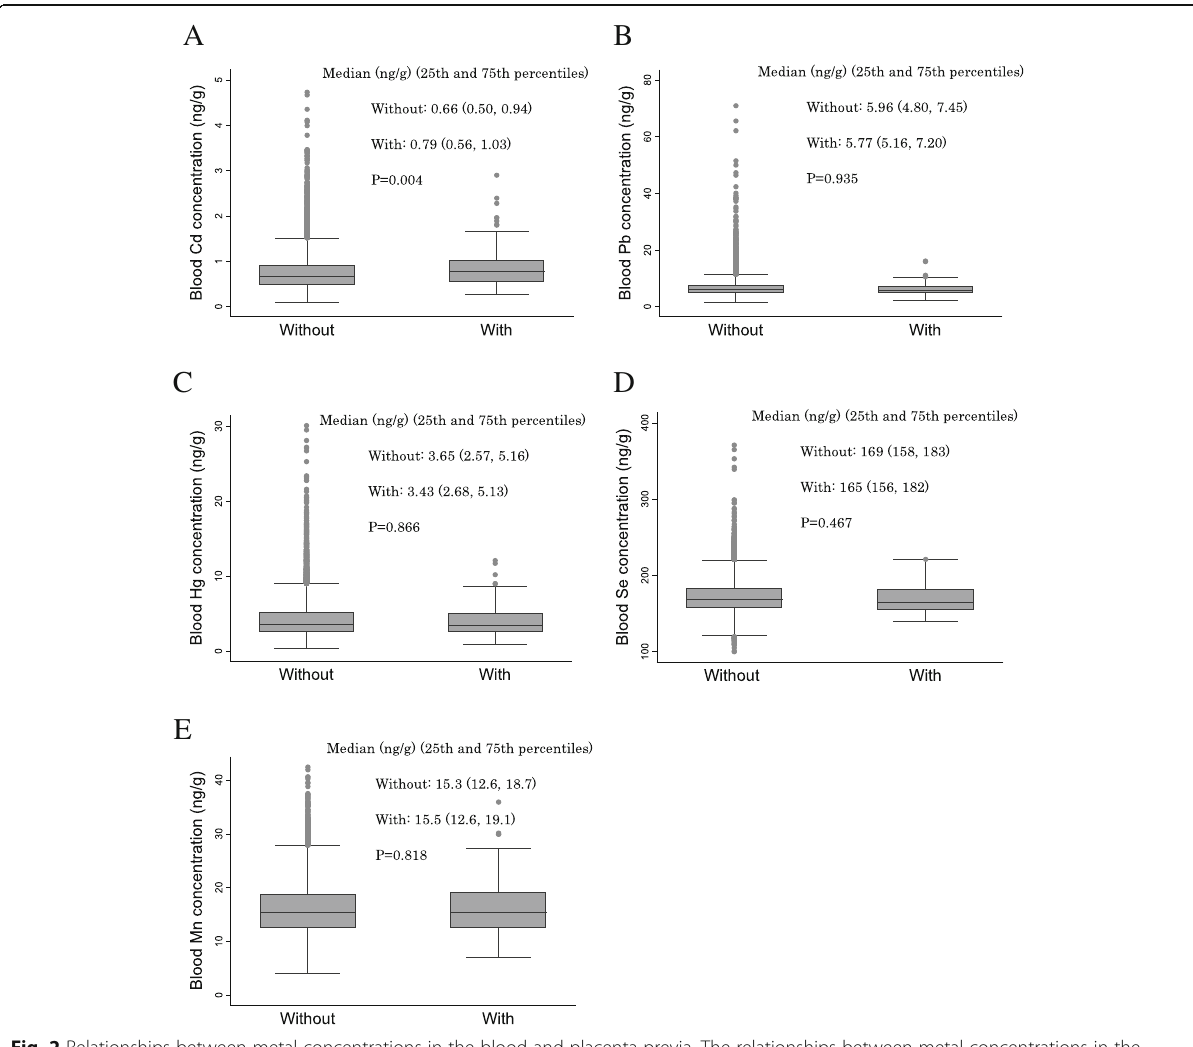
Fig. 2 Relationships between metal concentrations in the blood and placenta previa. The relationships between metal concentrations in the second/third trimester (T2) blood and placenta previa are shown. A box plot displays a box bordered at the 25th and 75th percentiles of the variable on the y-axis with a median line at the 50th percentile of each metal concentration. p values were calculated using the Mann-Whitney U test. a Relationship between Cd concentration and placenta previa. b Relationship between Pb concentration and placenta previa. c Relationship between Hg concentration and placenta previa. d Relationship between Se concentration and placenta previa. e Relationship between Mn concentration and placenta previa. Cd, cadmium; Pb, lead; Hg, mercury; Se, selenium; Mn,